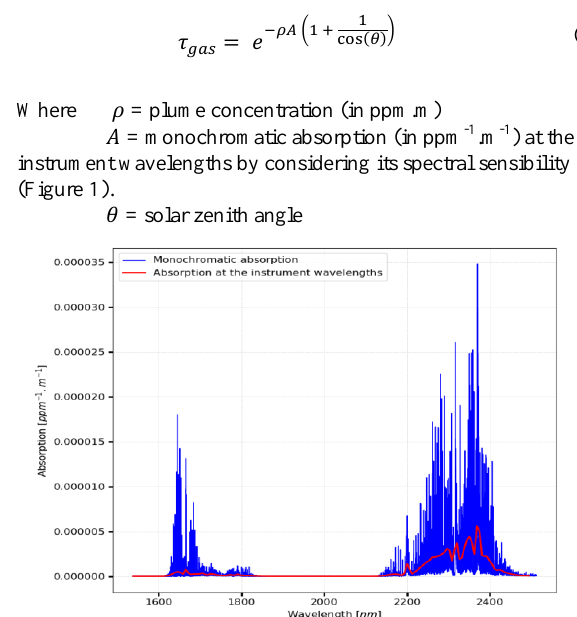
Figure 1 . Methane monochromatic absorption in ppm -1 .m -1 of the database (Sharpe, 2004) in blue line and the methane absorption in ppm -1 .m -1 convolved by the spectral sensitivity of the hyperspectral instrument in red line.